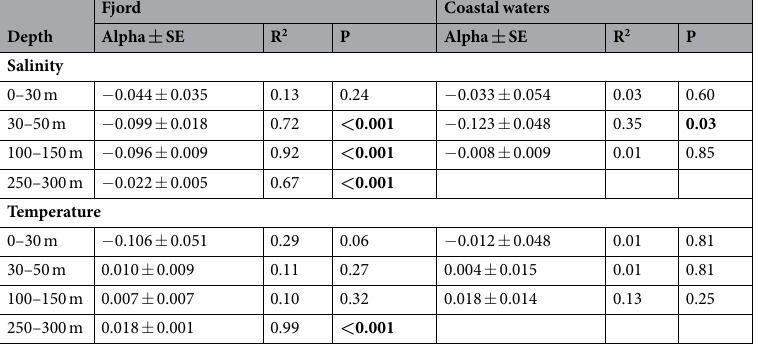
Table 1. Result of linear regressions of changes in salinity and temperature 2003–2015 along the hydrographical transect (split into two; fjord and coastal waters) in NE Greenland. Significant regressions are shown in bold.